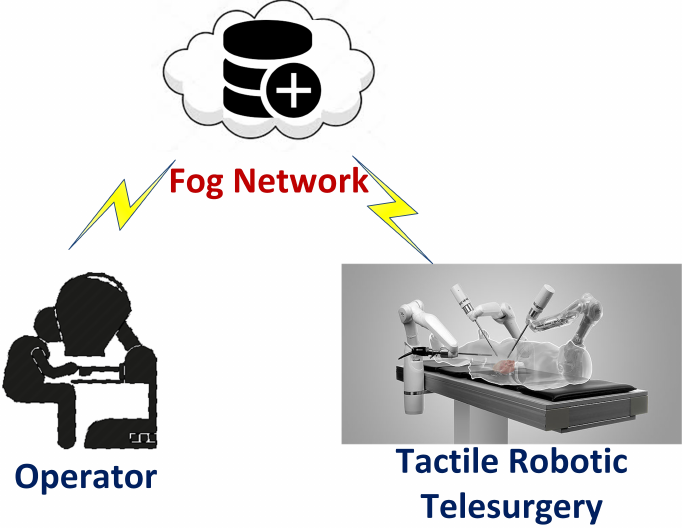
Figure 6. Robotic telesurgery with a master as ‘operator’ and slave as